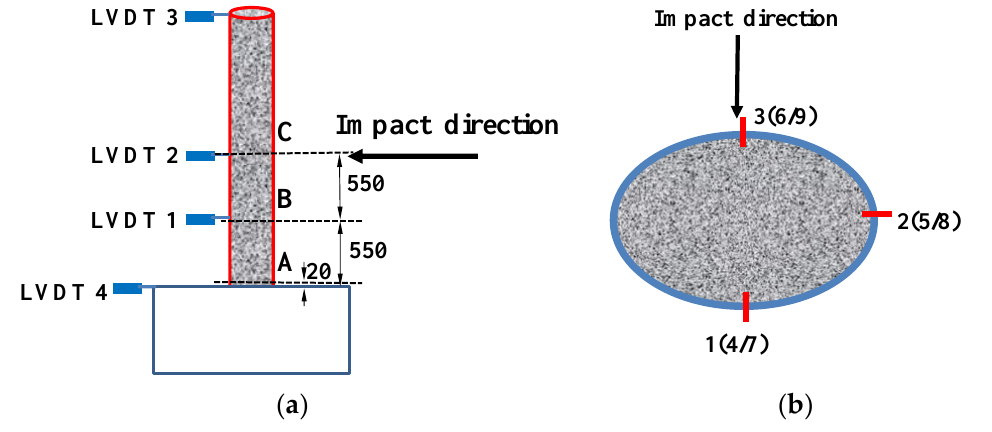
Figure 3. Location distributions of ( a ) LVDTs and ( b ) Strain gauges.